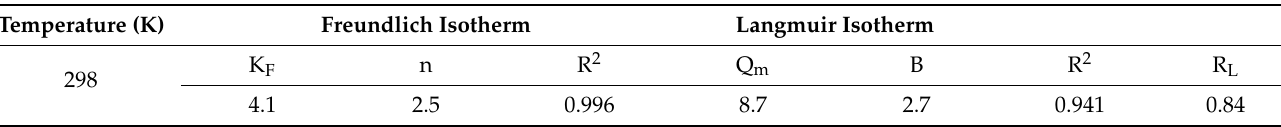
Figure 5. Isothermal adsorption of TPC by GAC/Cu(BDC) MOFcomposite at a temperature of 298 k, initial TPC 440 (mg/L), pH = 4.0, 2% by weight dosage, and 4 h contact time. Table 4. Freundlich and Langmuir parameters, and regression coefficients at temperatures for the adsorption of TPC by GAC/Cu(BDC) MOF composite with a 2% by weight dose, a temperature of 298 K, pH of 4.0, and 4 h contact time.